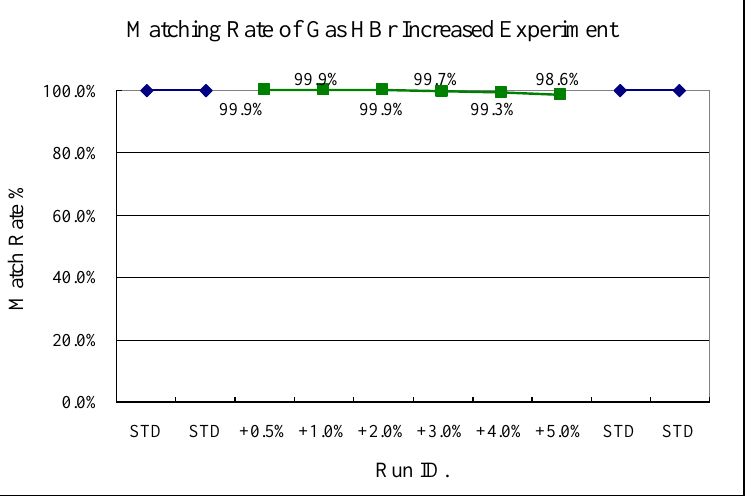
Figure 11. Experiment 2, HBr variance tested from 251.25 to 262.5 sccm (STD = 250 sccm). Matching Rate of Gas HBr Increased Experiment